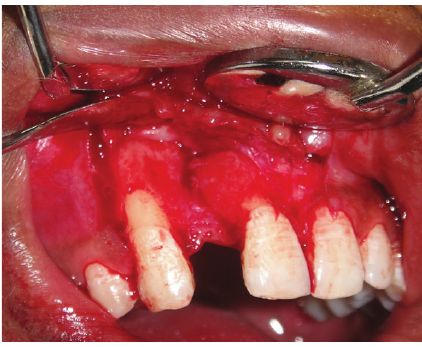
Figure 6: Defect at the edentulous site as viewed on surgical exposure.